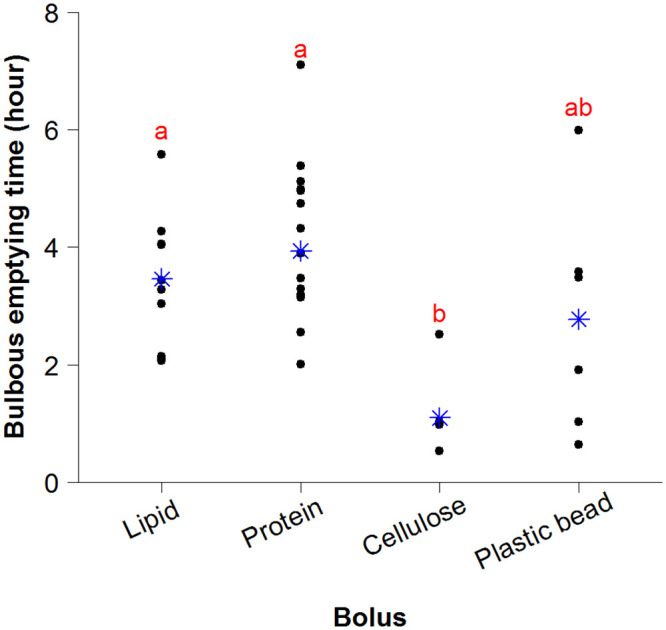
Evacuation time of Segment 1 (the bulbous).Analysis of intestines administered different boli (lipid, protein, cellulose or plastic bead) in vitro. Black dots refer to individual intestines, blue stars to mean for each treatment. Letters indicate significant differences in time to emptying of the bulbous between treatments (ANOVA followed by Tukey HSD; n = 11 for lipid, n = 12 for protein, n = 6 for cellulose or plastic bead).